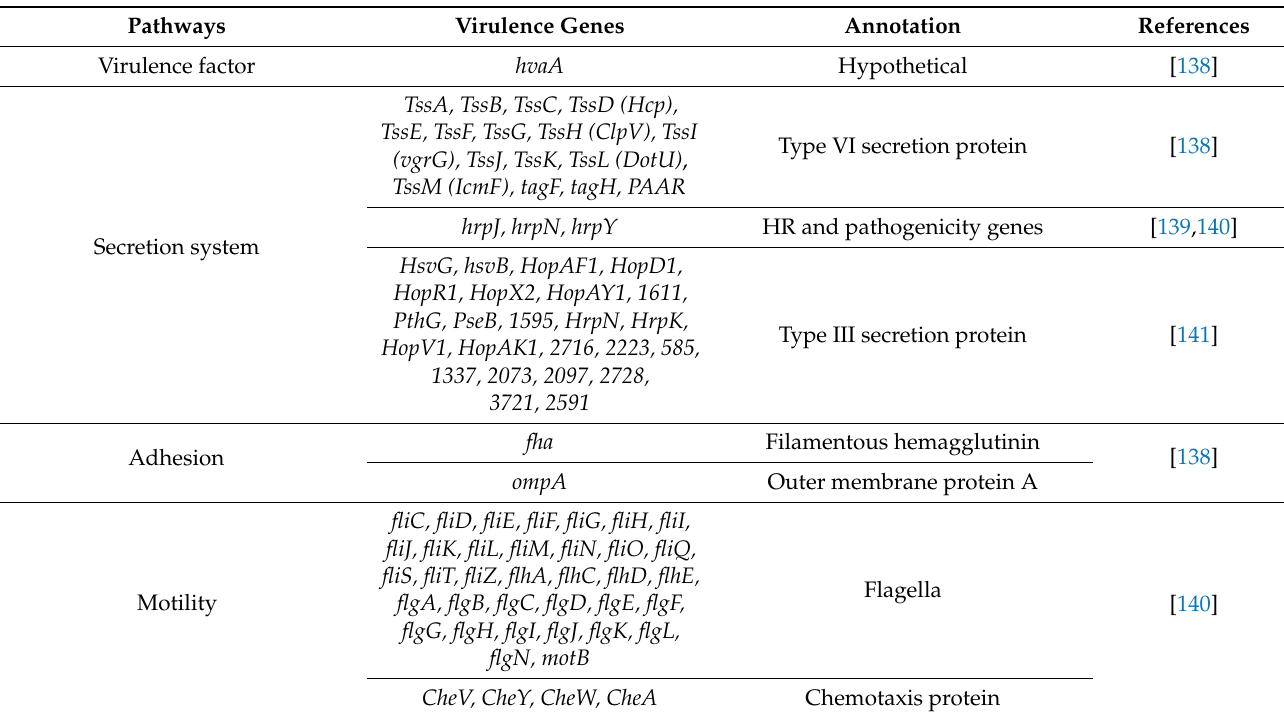
Table 4. The pathogenicity and virulence genes annotated in the genomes of P. agglomerans .